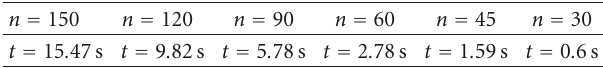
Table 1: Computational complexity of the DP solution.